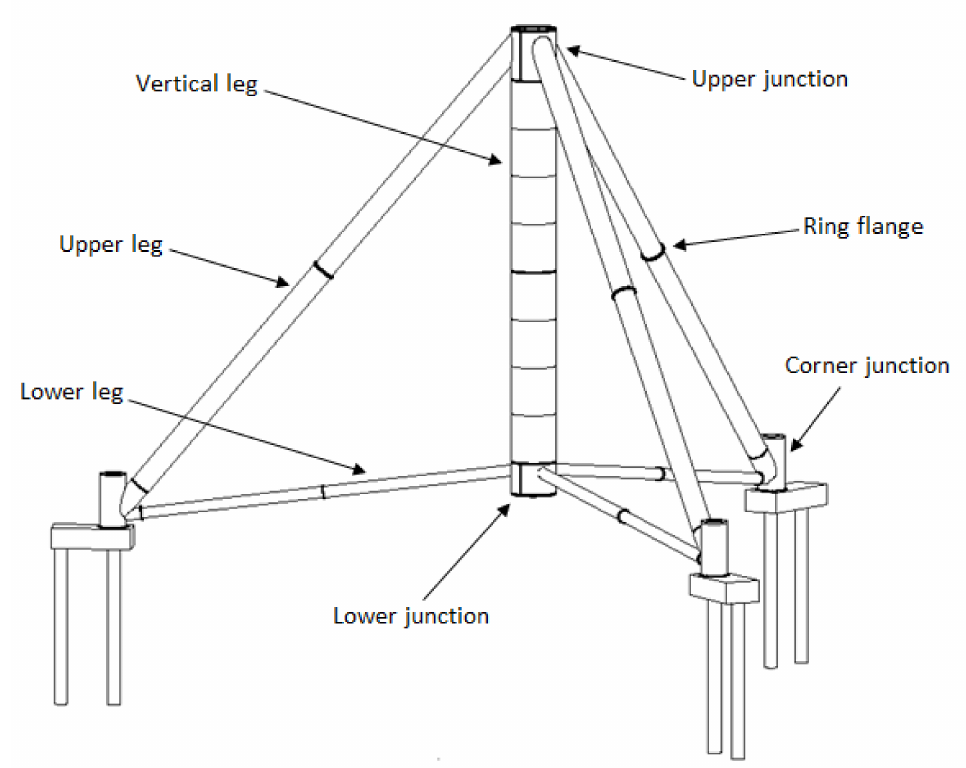
Figure 2. Main parts of tripod support